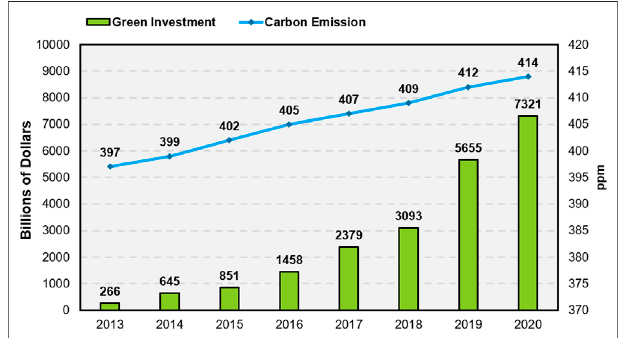
FIGURE 1 | Global green investment and carbon emissions. The bar chartrepresentstheamountofgreeninvestment(inbillionsofdollars).Theline gragh representsthe carbon emissions released into the atmosphere (in parts per million). Source: